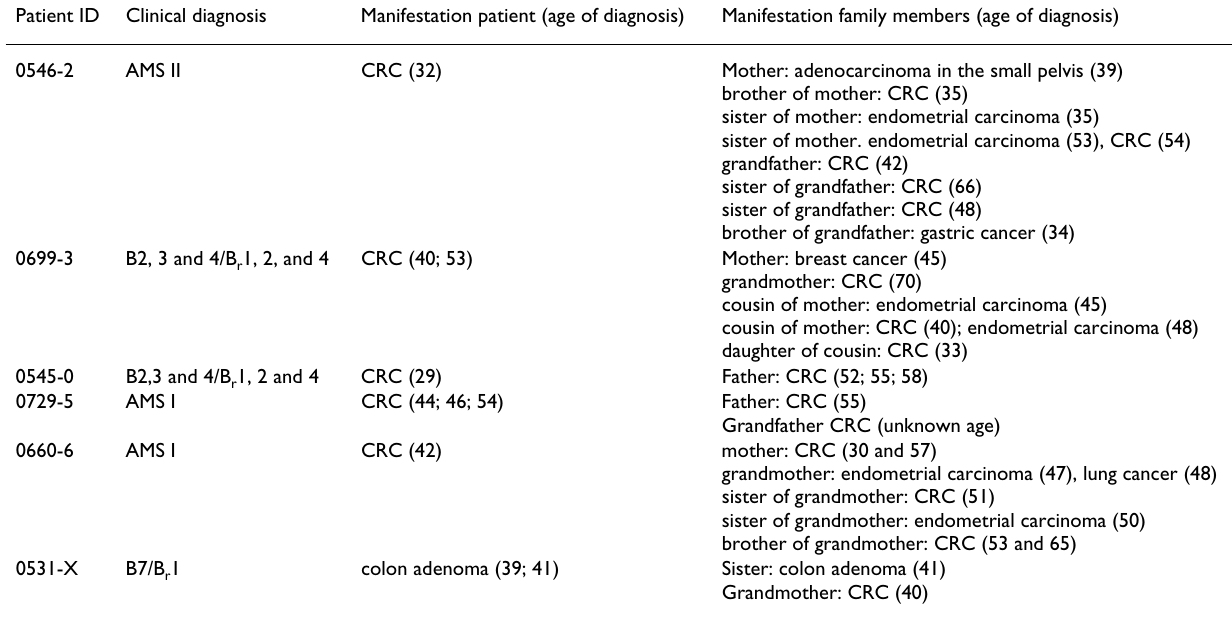
Table 1: Pedigree information and clinical diagnosis of the investigated patients Patient